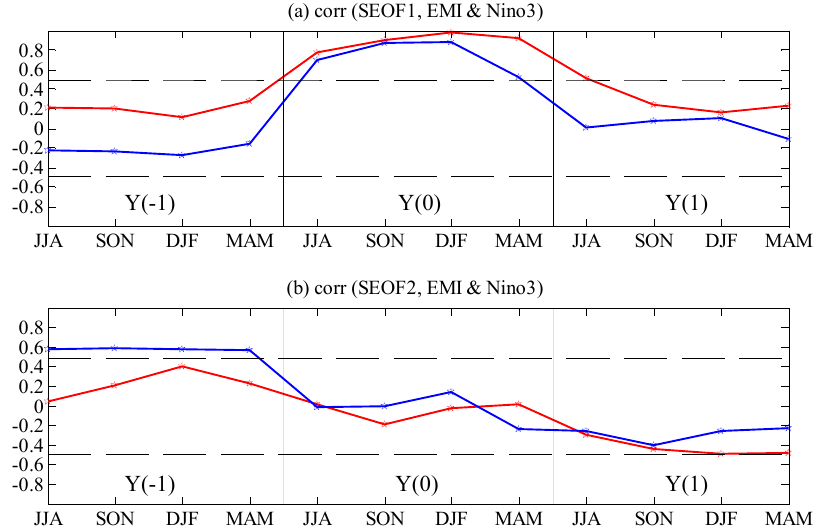
Figure 9. ( a ) Lagged correlations of the first SEOF PC with the EMI (red line) and Niño3 index (blue line); ( b ) lagged correlations between the second SEOF PC and the EMI (red line) and Niño3 index (blue line). Year( − 1) (Year(1)) denotes that the PC lags behind (leads) its counterpart by one year; Year(0) denotes simultaneous correlation. JJA is boreal summer, SON is boreal autumn, DJF is boreal winter, and MAM is boreal spring.